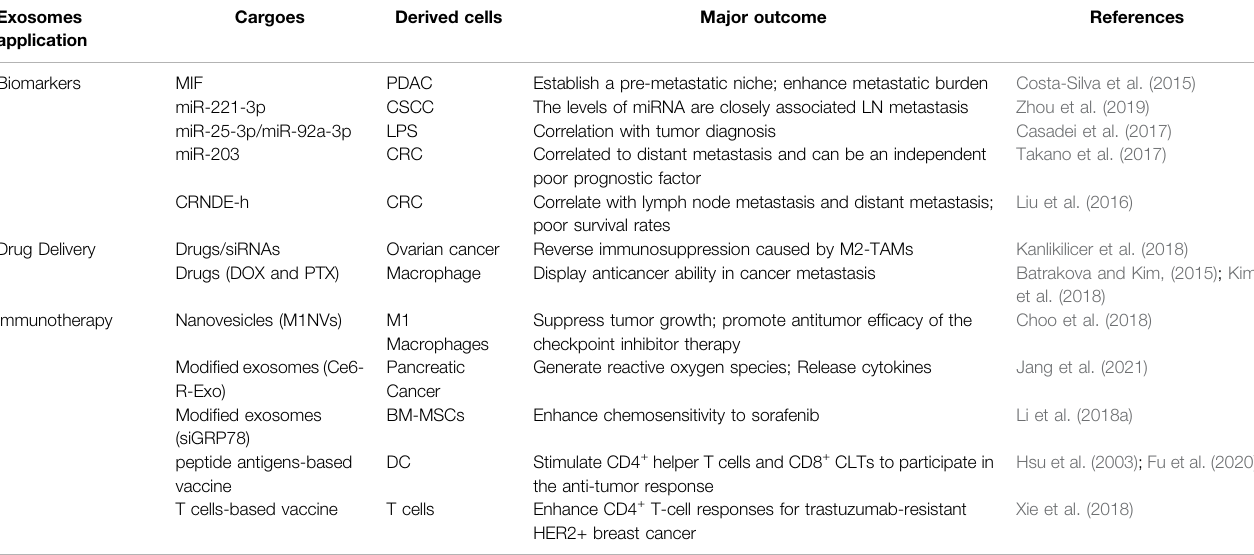
TABLE 3 | Clinical applications for exosomes in different types of